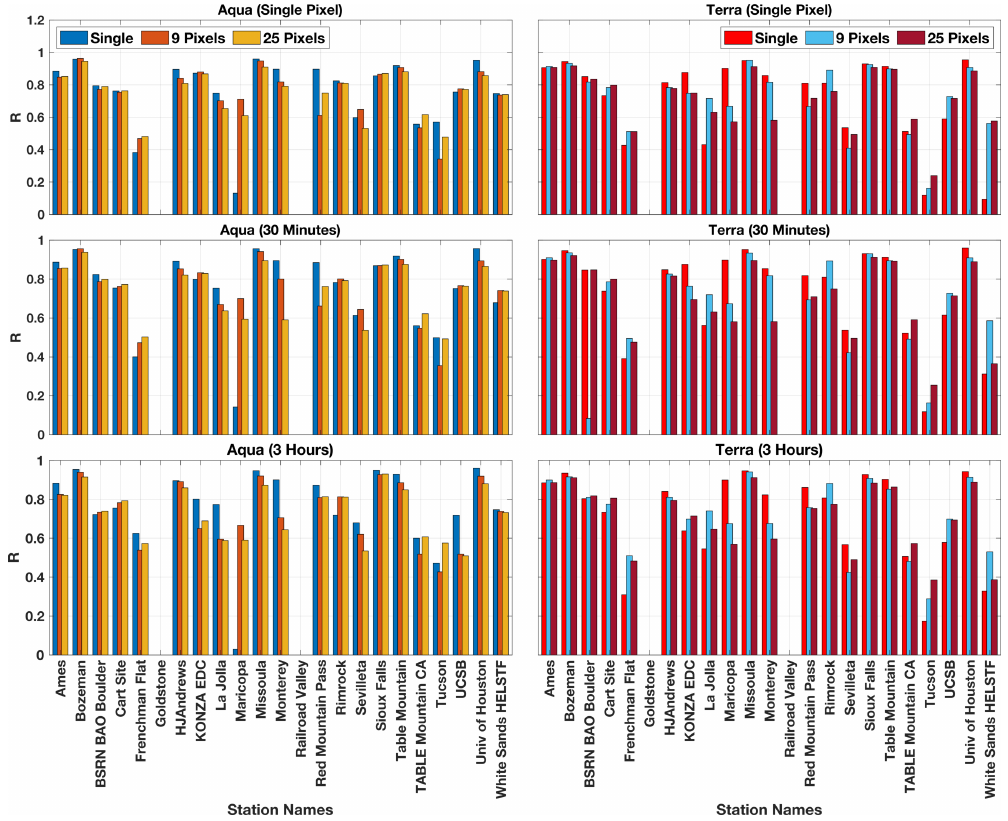
Figure 8. Pearson correlation coefficient between MODIS (Aqua and Terra) DT AOD (land and ocean) and AERONET AOD over 23 stations at different combinations of temporal and spatial averaging